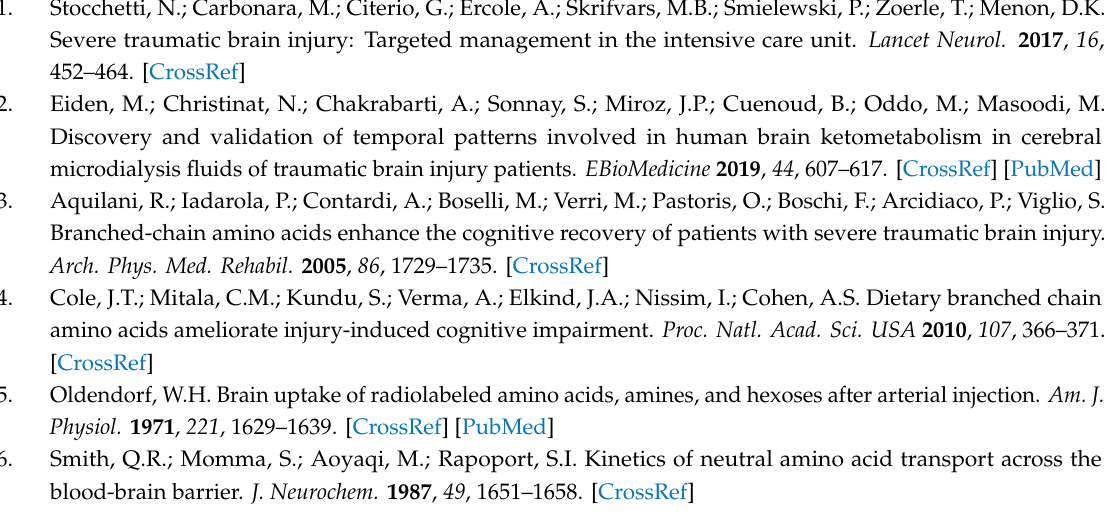
Table S1: Spearman correlation coe ffi cient for all possible comparisons of CMD and plasma data. Author Contributions: M.M. and S.S. designed this study. N.C. performed the LC–MS measurements. J.T., S.S. and A.W. performed the cell experiment. S.S. analyzed the data. M.M., S.S., and A.C. interpreted the